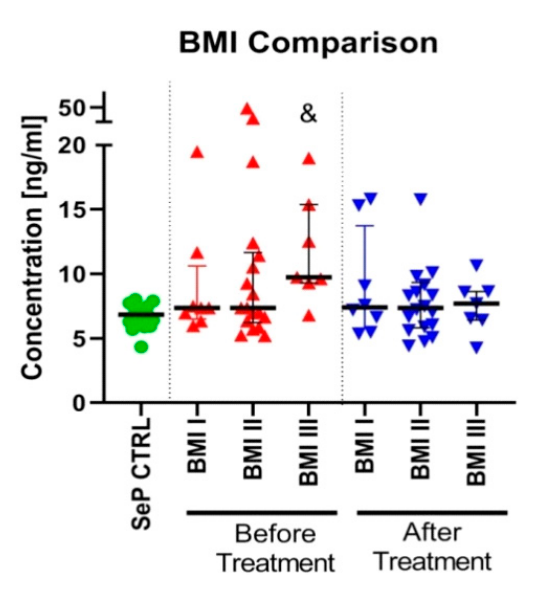
Figure 2. The median values of SeP serum levels in BMI subgroups before and after treatment. & indicates the existence of a trend due to a small number of “n” in the subgroups ( p < 0.1). A multivariate linear regression analysis, after considering lipid parameters and blood morphological parameters, revealed that WBC and RBC were independently related to SeP concentration before the treatment (**), as shown in Table 4. (BMI I: n = 8; BMI II: n = 18; BMI III: n = 7). Table 4. Parameters that independently predict the levels of SeP before treatment.